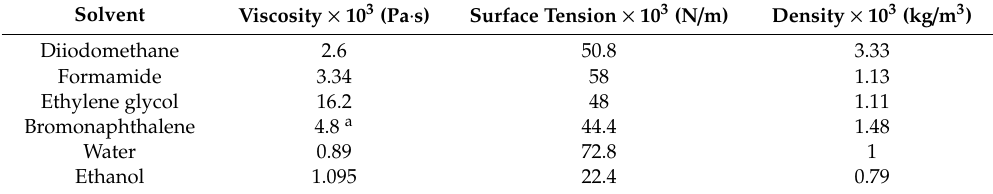
Table 1. Liquid properties of solvents at 25 ◦